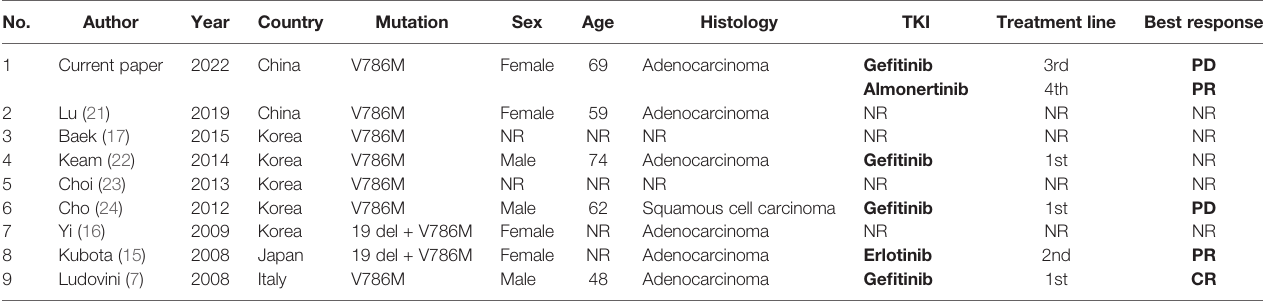
TABLE 1 | Cases reported of EGFR exon 20